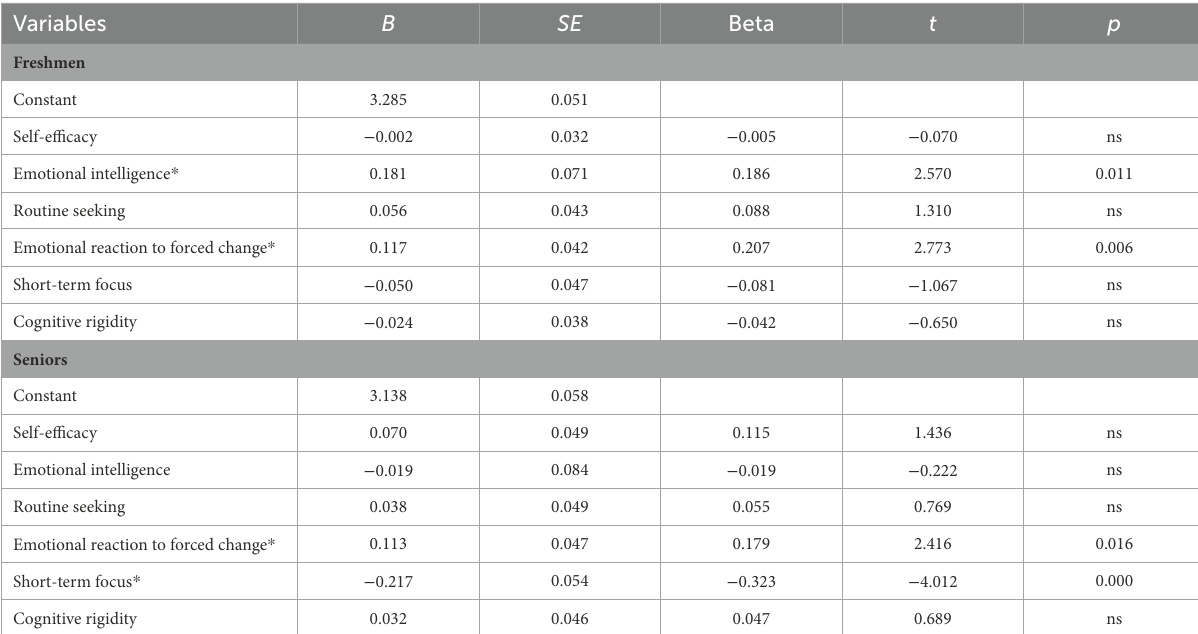
TABLE 2 Regression analyses.